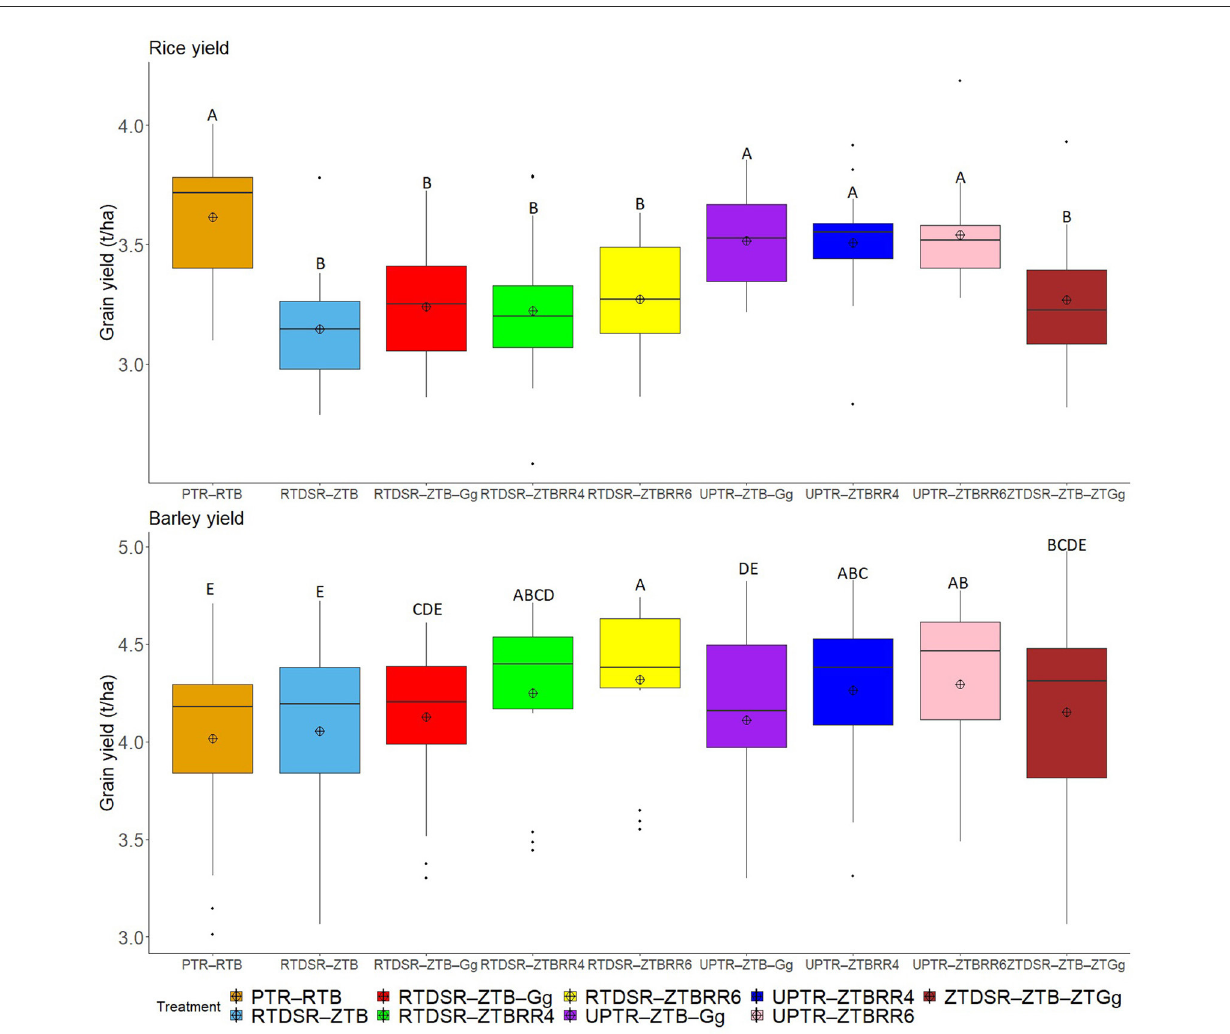
FIGURE1 Effect of tillage and residue management practices on rice and barley grain yield. RTDSR–ZTB, reduced till direct seeded rice–zero till barley; RTDSR–ZTB–Gg, reduced till direct seeded rice–zero till barley–green gram; ZTDSR–ZTB–ZTGg, zero till direct seeded rice–zero till barley–zero till green gram; RTDSR–ZTBRR4, reduced till–direct seeded rice–zero till barley + rice residue at 4 t/ha; RTDSR–ZTBRR6, reduced till direct seeded rice–zero till barley + rice residue at 6 t/ha; UPTR–ZTB–Gg, un-puddled transplanted rice–zero till barley–green gram; UPTR–ZTBRR4, un-puddled transplanted rice–zero till barley + rice residue 4 t/ha; UPTR–ZTBRR6, un-puddled transplanted rice–zero till barley + rice residue 6 t/ha; PTR–RTB, puddled transplanted rice–reduced till barley; R, residue. Box plots with different capital letters are significantly different ( p < 0.05) using DUNCAN’s multiple range